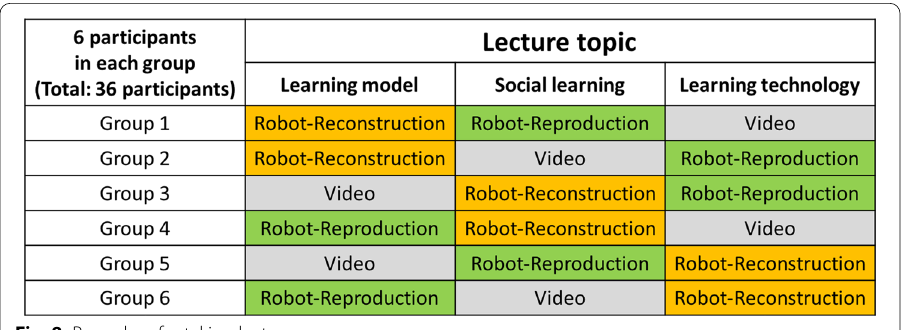
Fig. 8 Procedure for taking lectures